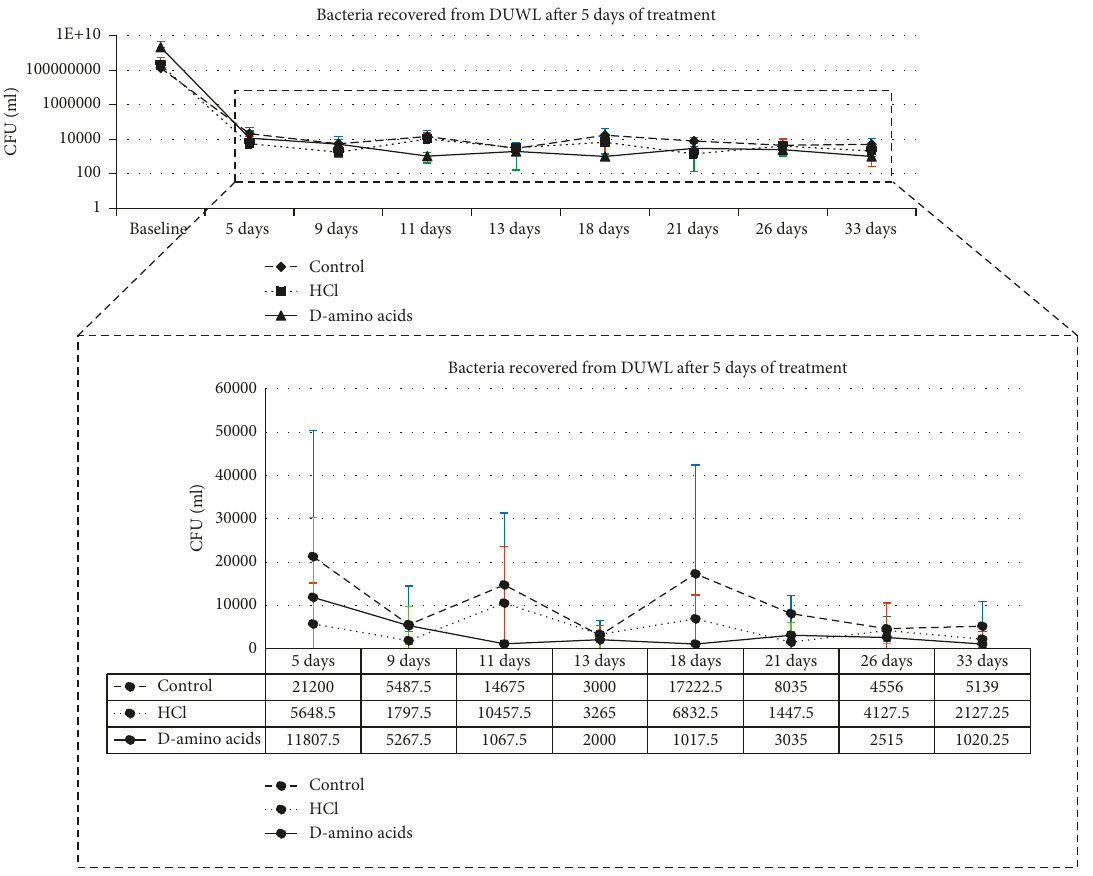
Figure 5: Bacterial contamination in DCU output water collected every 2-3 days for 4 weeks after the DUWLs were flushed with distilled water (control), D-amino acids mixture (D-amino acids, 10 mM each), or 0.1 M hydrochloric acid (HCl) for 5 days. A treatment of the DUWLs with D-amino acids reduced bacterial contamination in dental unit output water more than was seen in the control and HCl group.